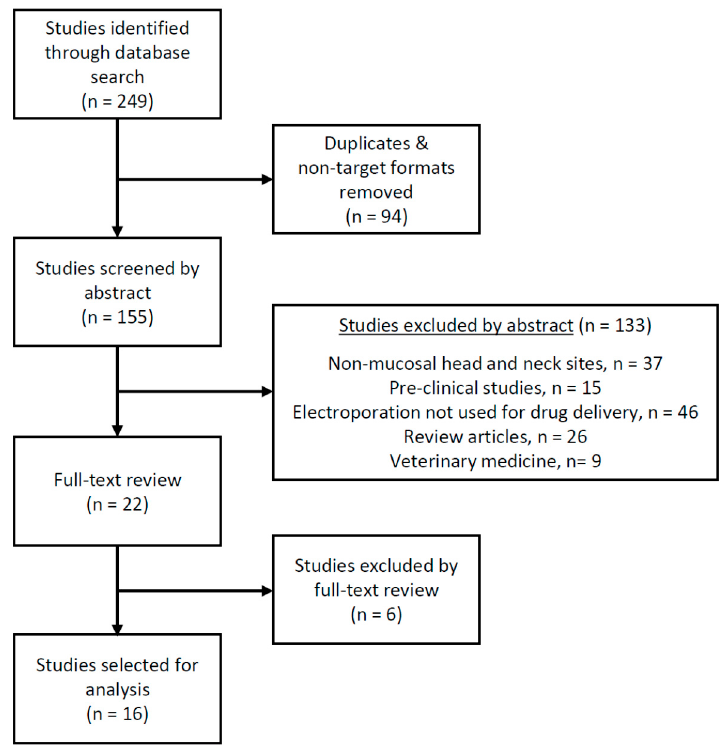
Figure 1. Study selection based on the inclusion and exclusion criteria.